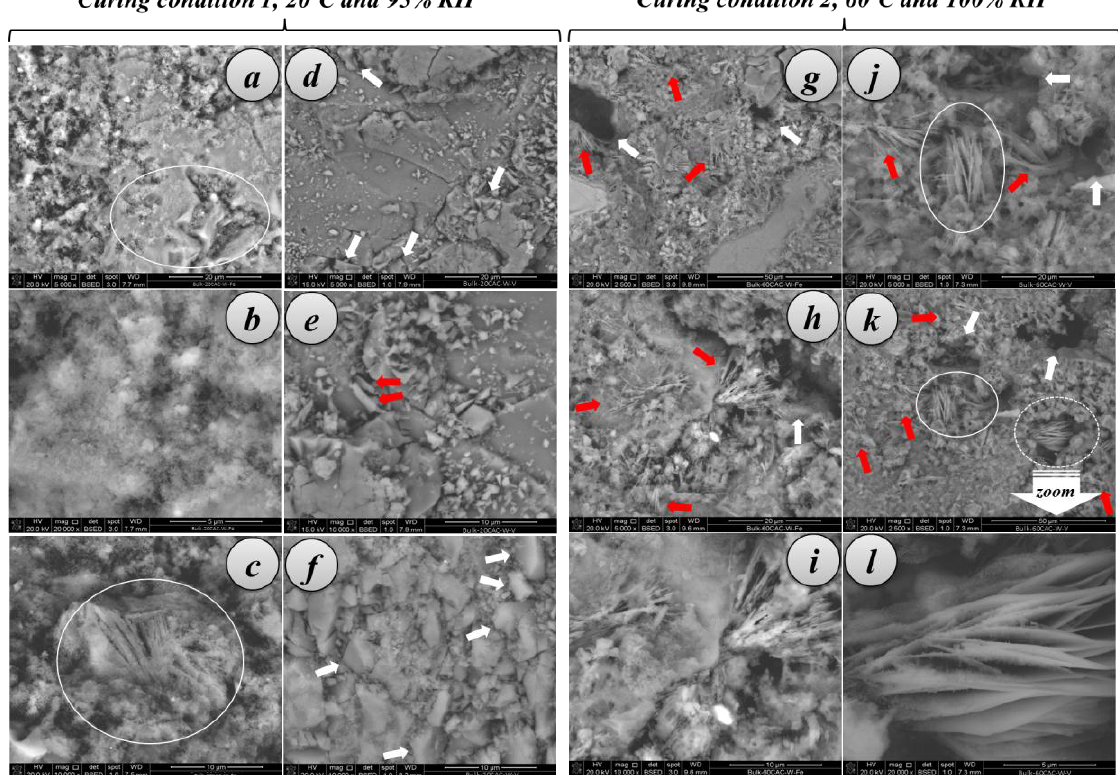
Figure 11. Microstructural examination of HAC mortars (28 curing days) with nano-structured additives (2.5 wt. %): ( a – c ) Micrographs for samples with Fe-TiO 2 after curing condition 1 (20 °C and 95% RH); ( d – f ) Micrographs for samples with V-TiO 2 after curing condition 1; ( g – i ) Micrographs for samples with Fe-TiO 2 after curing condition 2 (60 °C and 100% RH); ( j – l ) Micrographs for samples with V-TiO 2 after curing condition 2. An enlargement of the encircled dotted area in ( k ) is shown in ( l ).